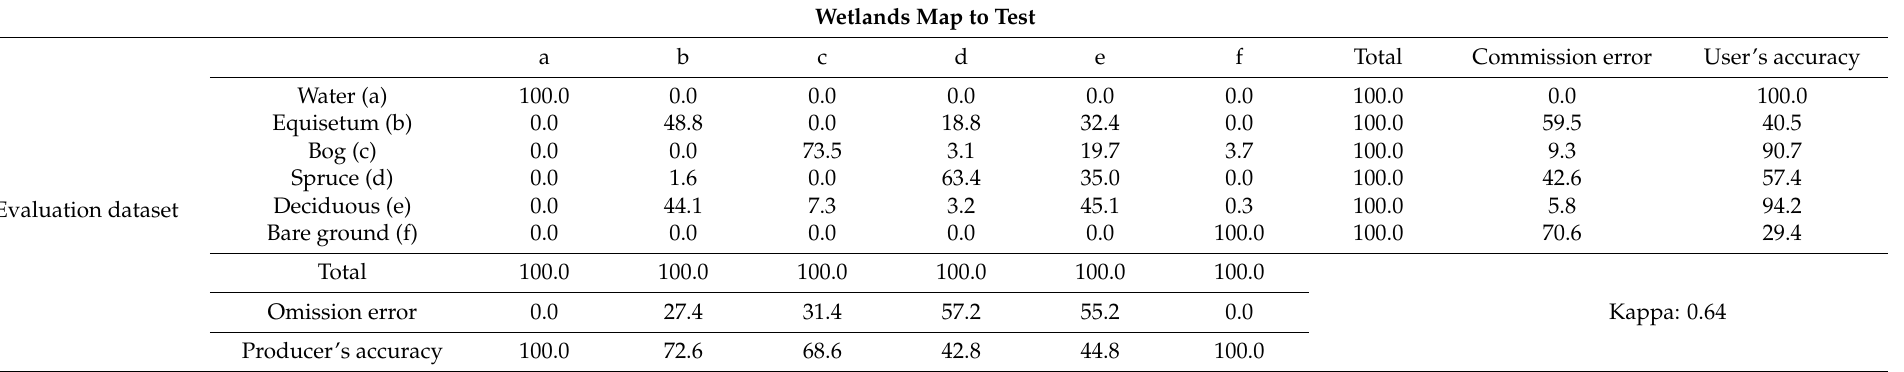
Table A4. Confusion matrix for area B SAM classification. Results in